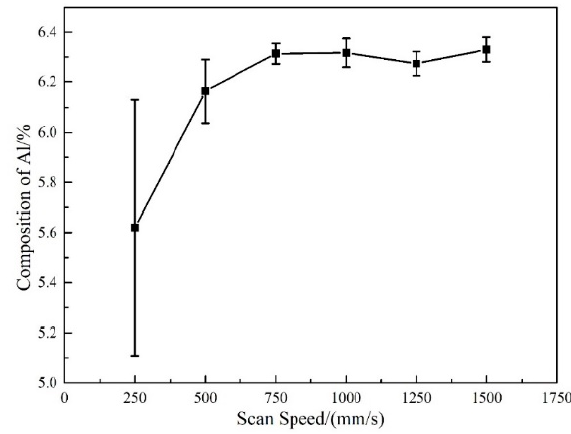
Figure 5. E ff ect of scanning speed on the mass fraction of Figure 5. Effect of scanning speed on the mass fraction of Al.